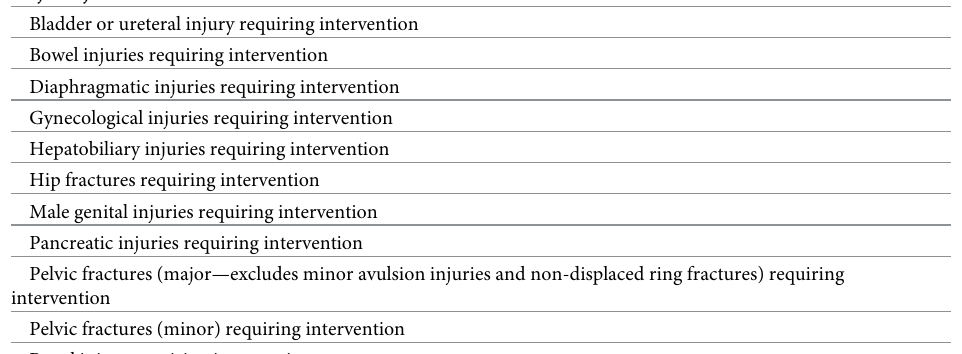
Table 1. Classification of injuries based on Delphi